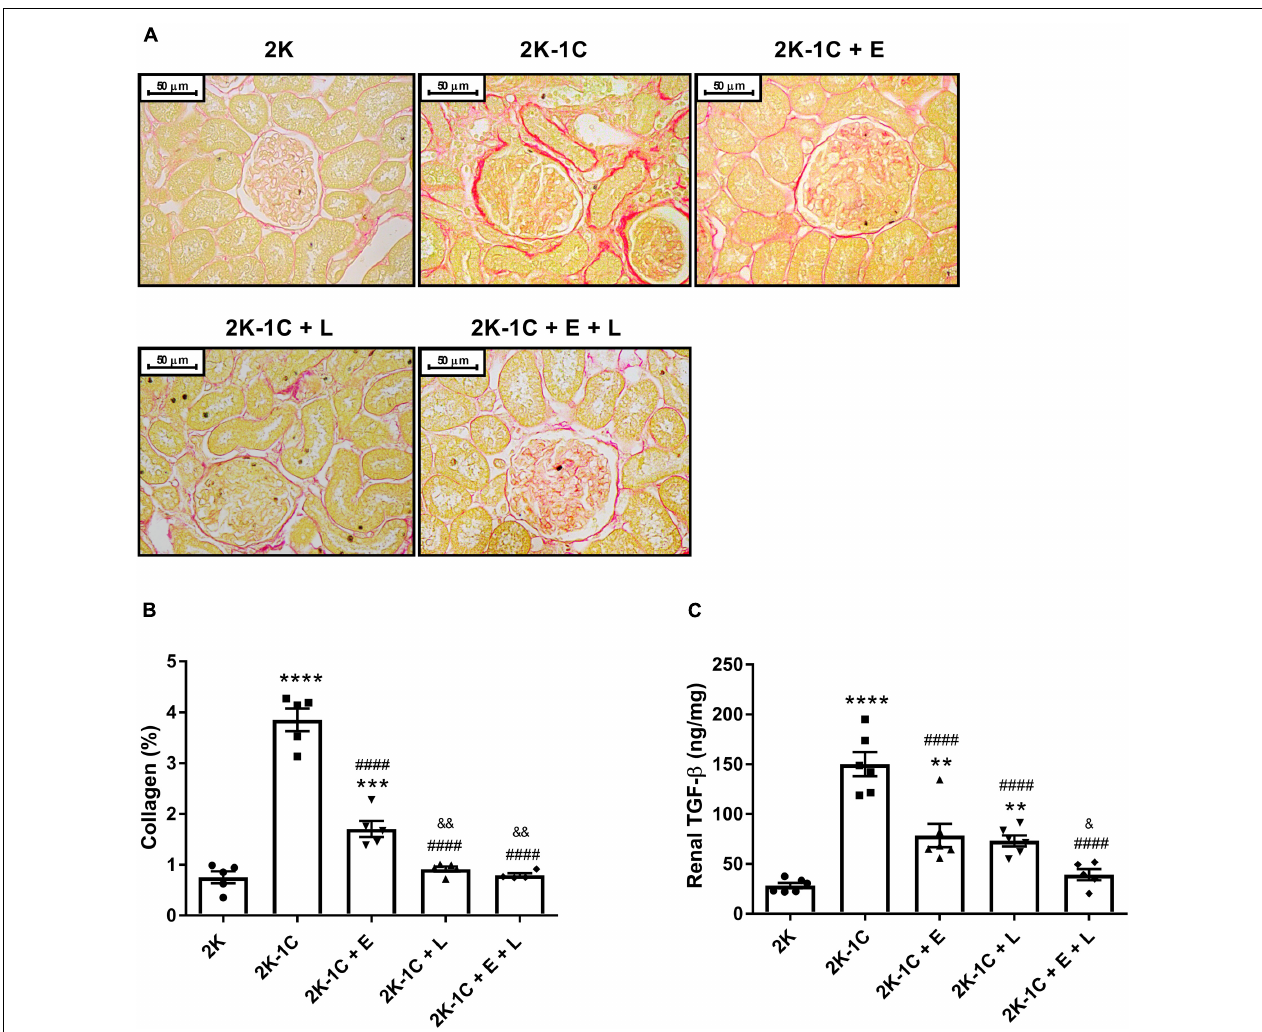
FIGURE 5 | Effect of dual versus single RAS blockade on fibrosis of the non-clipped kidney of renovascular hypertensive rats. (A) Representative images of Picrosirius Red staining non-clipped kidney sections (400 × magnification) from renovascular-hypertensive rats treated with enalapril (2K-1C + E, 20 mg/kg/day), losartan (2K-1C + L, 30 mg/kg/day), enalapril plus losartan (2K-1C + E + L, 30 and 20 mg/kg/day, respectively), or vehicle (2K-1C) and vehicle-treated control rats (2K). The scale bar shows 50 µ m. (B) Quantification of Picrossiuris Red staining kidney sections. The levels of non-clipped kidney collagen were expressed as percent of the total cross-section area. (C) The concentration of TGF- β was measured in non-clipped kidneys homogenate by ELISA. The values represent individual measurements and the means ± SEM. ** P < 0.01, *** P < 0.001, and **** P < 0.0001 vs. 2K; #### P < 0.0001 vs. 2K-1C; & P < 0.05 and && P < 0.01 vs. 2K-1C +